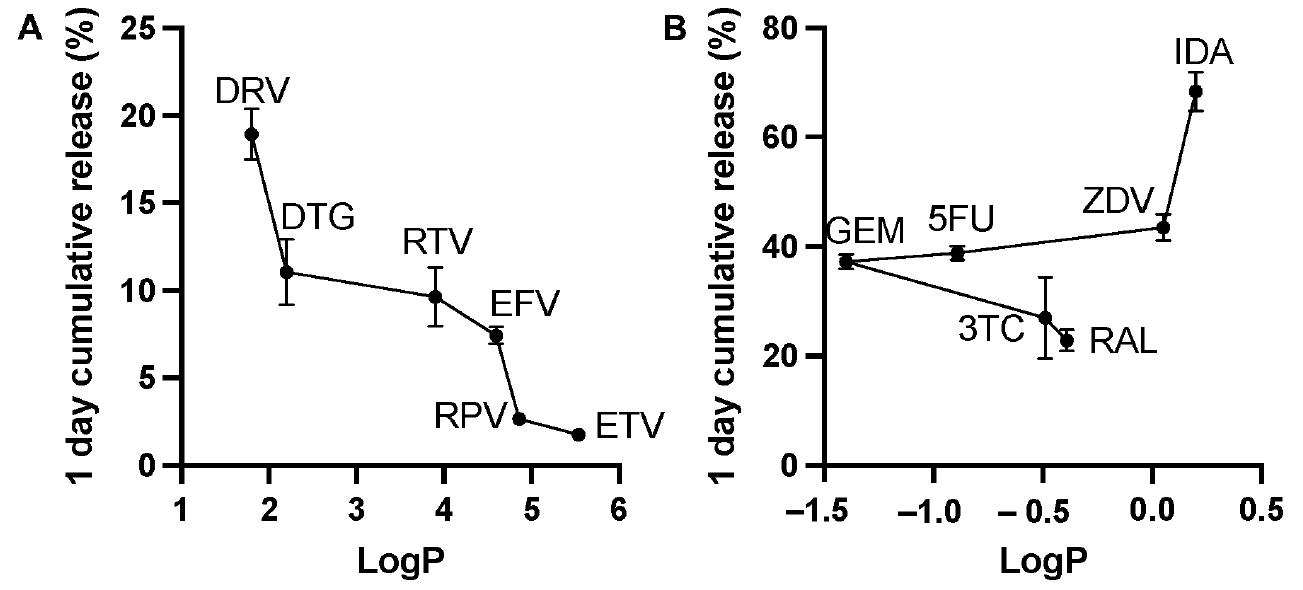
Figure 2. Initial in vitro burst release quantified 24 h post ISFI incubation in PBS (pH 7.4 with 2% solutol) at 37 °C plotted relative to drug logP. ( A ) burst release of 50 mg/g DRV (logP 1.8), DTG (logP 2.2), RTV (logP 3.9), EFV (logP 4.6), RPV (logP 4.8) and ETV (logP 5.5) ISFIs; ( B ) burst release of 50 mg/g GEM (logP −1.4), 5FU (logP −0.89), 3TC (logP −0.49), RAL (logP −0.39), ZDV (logP 0.05) and IDA (logP 0.2) ISFIs.